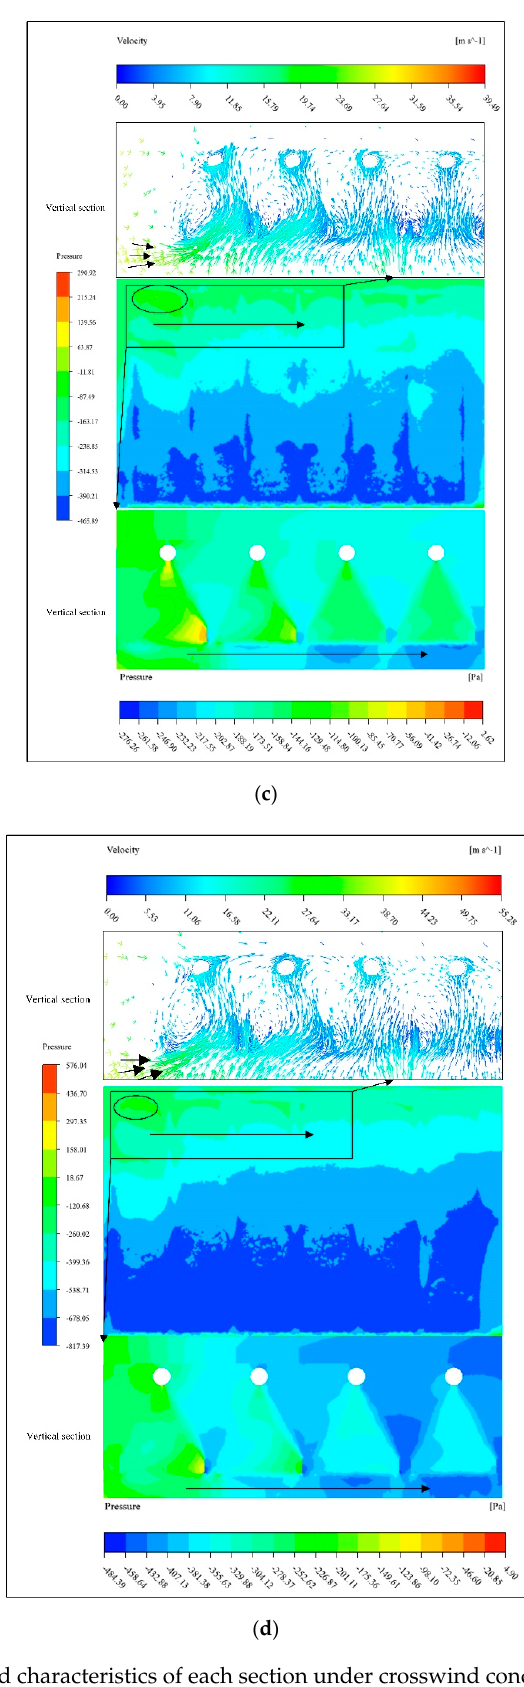
Figure 15. The flow field characteristics of each section under crosswind conditions. ( a ): u c = 4 m · s − 1 ; ( b ): u c = 12 m · s − 1 ; ( c ): u c = 20 m · s − 1 ; ( d ): u c = 28 m · s − 1